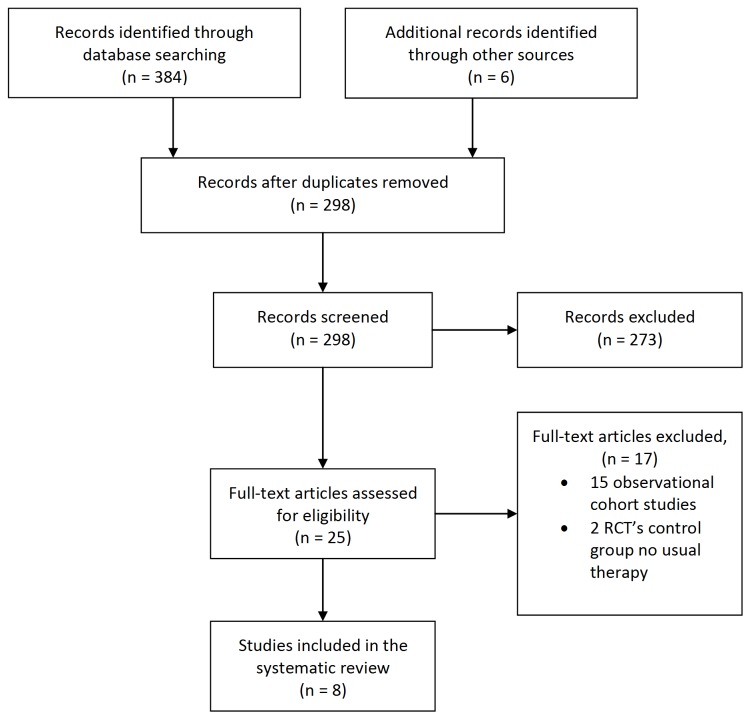
Description of search.Selection of trials investigating heart rate recovery.